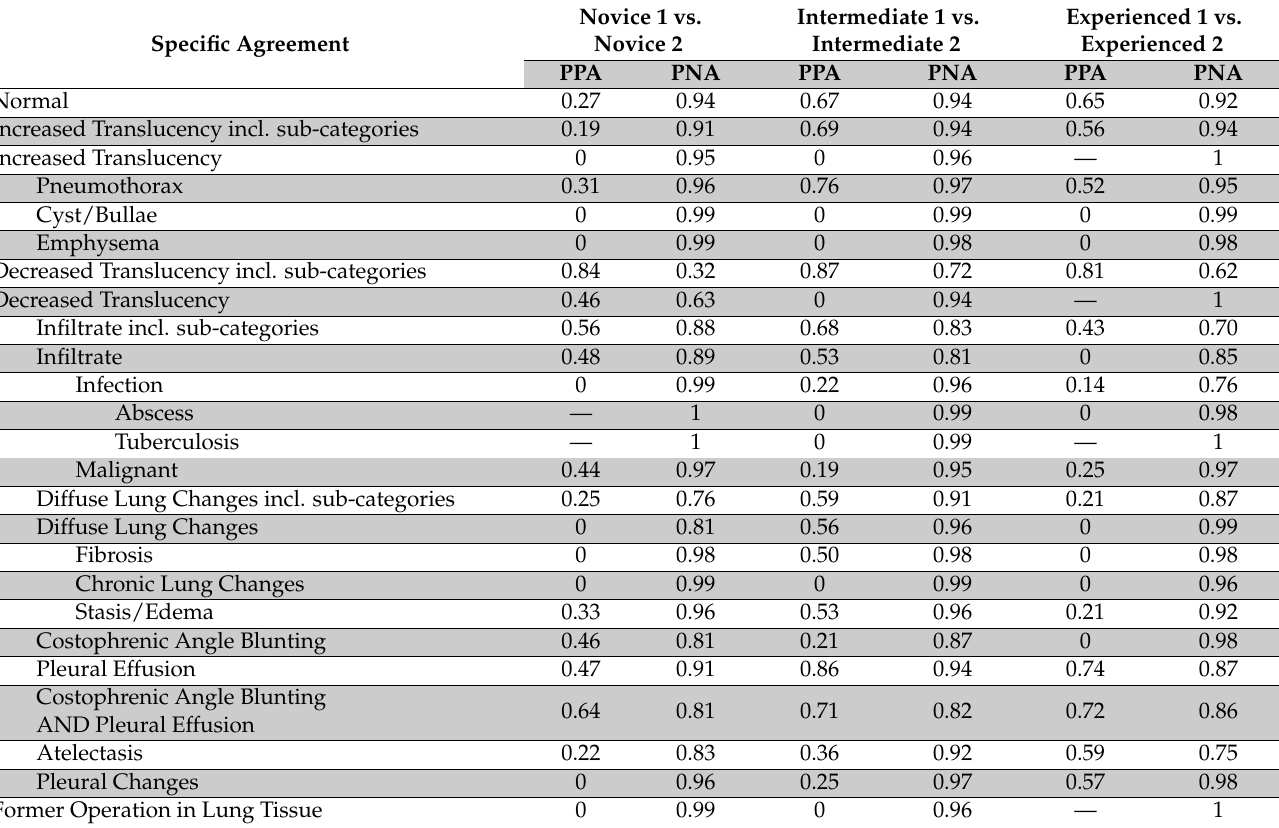
Table A2. Specific agreement for novice, intermediate, and experienced radiologists. PPA, Proportion of positive agreement; PNA, Proportion of negative agreement. Kappa: <0, poor; 0.01–0.20,